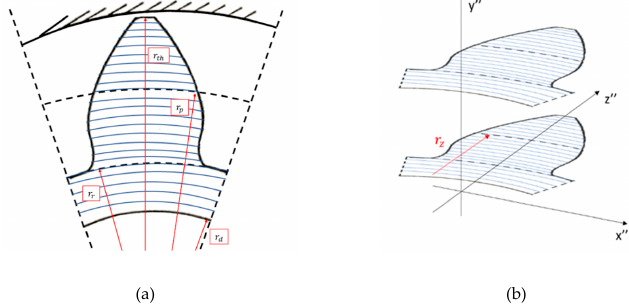
Figure 5. Reference tooth subdivision. ( a ) Tooth region considered to calculate the lateral losses ( b ) same region in 3D representation with the frame of reference adopted